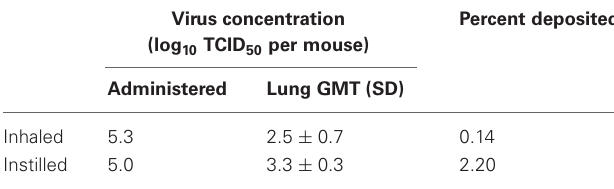
Table 2 | PR8 deposition in lungs.